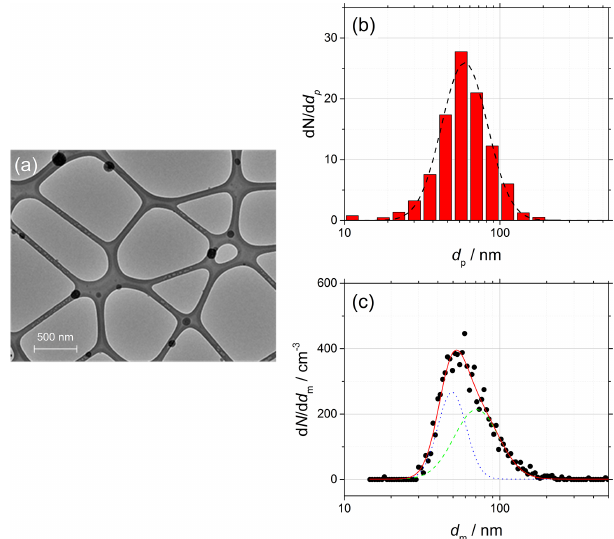
Figure 3. (a) TEM image of size-selected ammonium sulfate par- ticles (black quasi-spherical particles) deposited on a Lacey mesh, 6500 magnification. (b) Diameter of the particle projection d p ob- tained from TEM measurements (red bars) and single-mode log- normal fit (dashed black line). (c) Electrical mobility diameter d m obtained from SMPS measurements (black dots) and two-mode log- normal fit (solid red line) showing the two contributions (dotted blue and dashed green lines) according to Eq. (12).